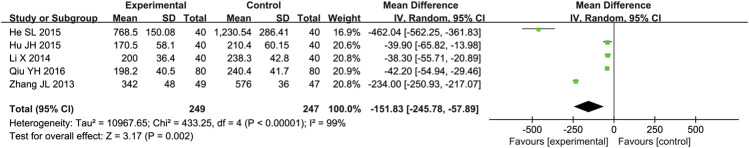
Forest plot of BNP.